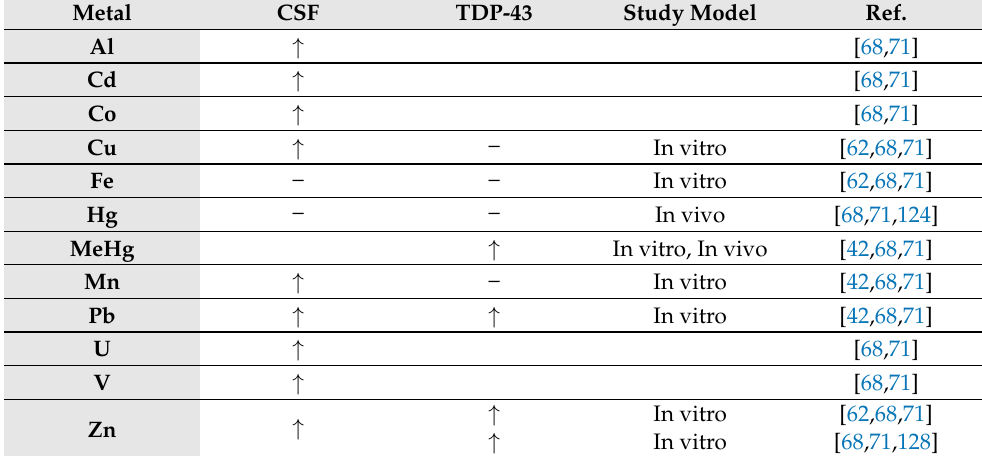
Table 1. Metals in cerebrospinal fluid (CSF) of ALS patients, and metals studied in relation to TDP-43 aggregation. In column 2, metals found to be significantly elevated ( ↑ ) or unchanged (–) in ALS CSF [68,71] are indicated. Columns 3 and 4 show metals demonstrated to induce ( ↑ ) or not to induce (–) aggregation of TDP-43 and the studies where these were studied, respectively [42,62,124,128]. Lead (Pb) and zinc (Zn) have both been shown to induce TDP-43 aggregation and to be significantly elevated in ALS CSF. Methyl mercury (MeHg) has not been studied in ALS CSF. CSF